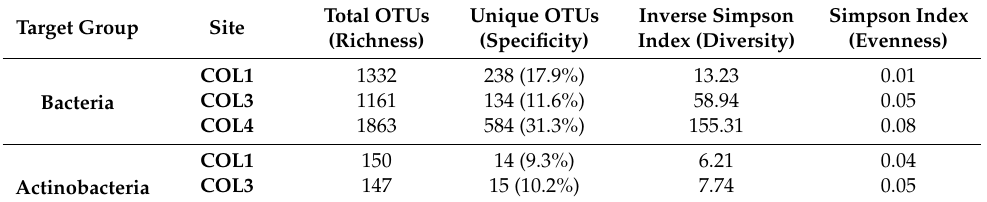
Table 1. Richness, specificity, diversity, and evenness of the bacterial and actinobacterial communities in the three moonmilk deposits of the “Grotte des Collemboles”. OTUs: operational taxonomic units.